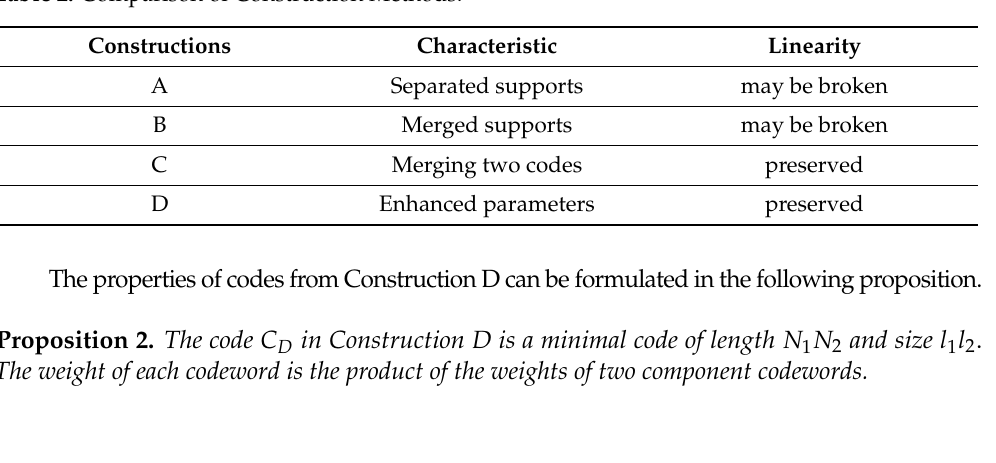
Table 2. Comparison of Construction